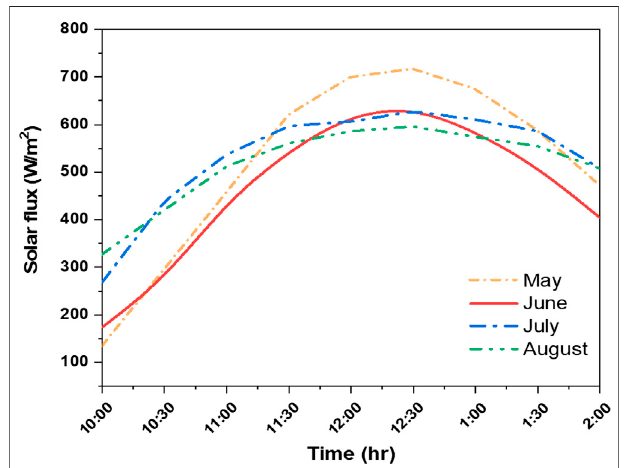
FIGURE 4 | Solar intensity of summer months.